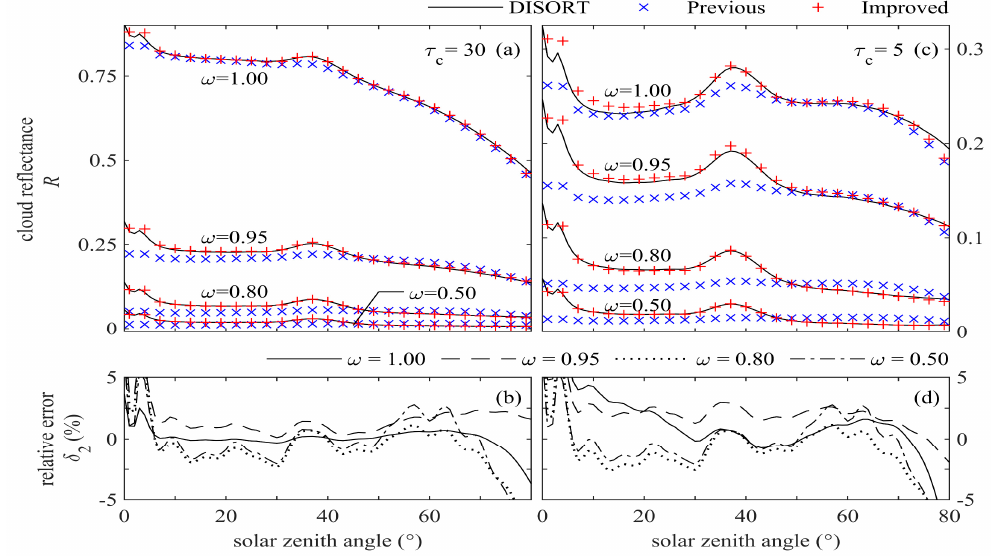
Figure 6. The ( a ) reflectance and ( b ) relative error of the parameterization in cases with different single-scattering albedos ( ω ) and solar zenith angles, compared with the previous study [32] and DISORT. ( c , d ) Similar to Figure 4a,b, but for optically thinner clouds.